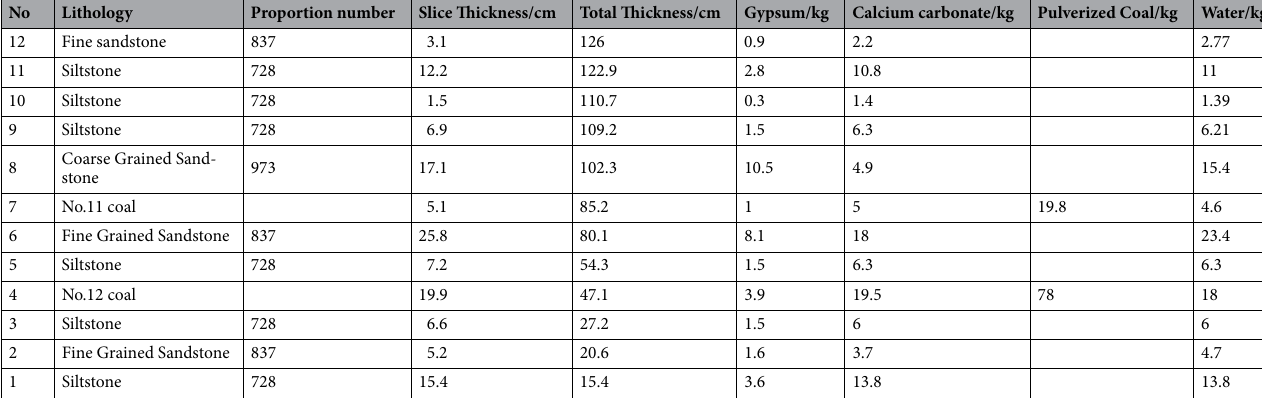
Table 1. Ratio of similar